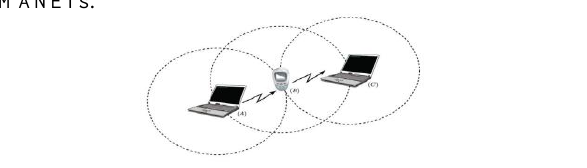
Figure 1. Example of a message transmission in an ad-hoc